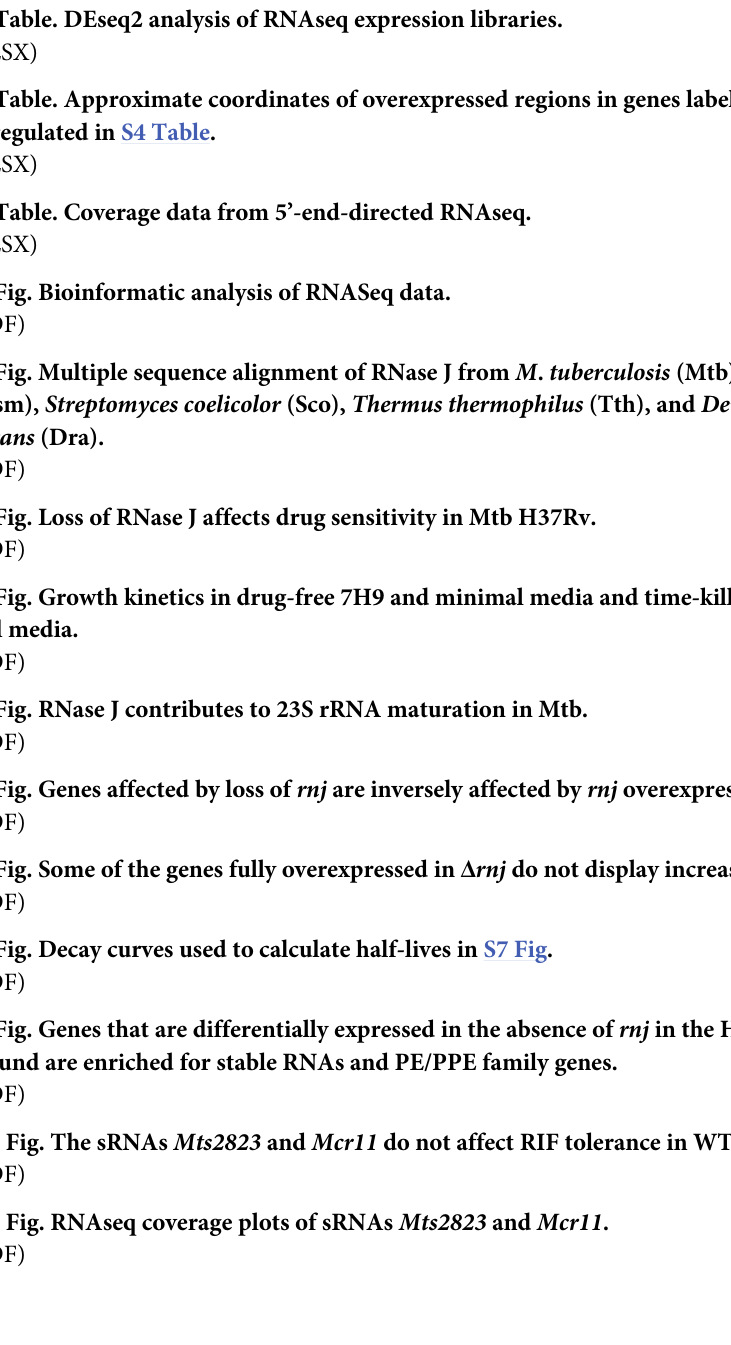
S11 Fig. RNAseq coverage plots of sRNAs Mts2823 and Mcr11